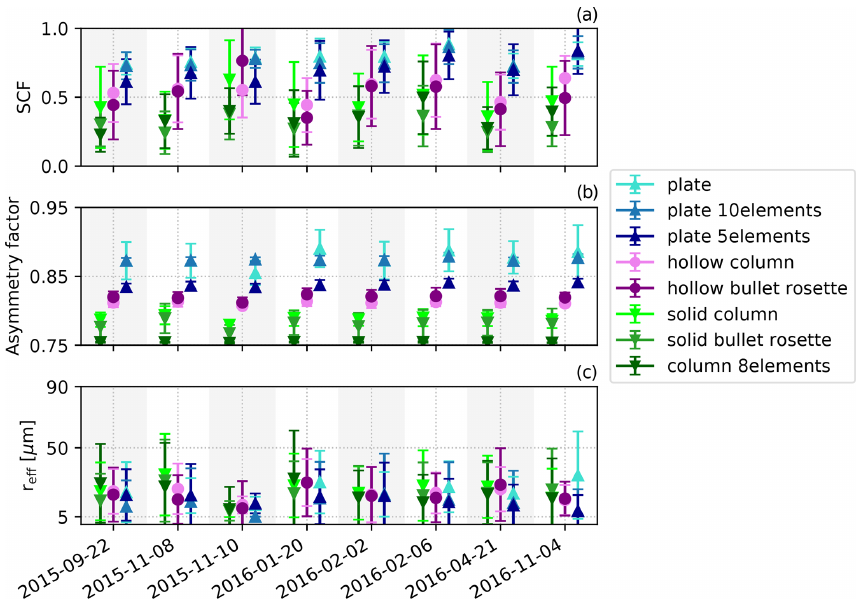
Figure 6. Retrieval results for all 8d listed in Table 1 and for all eight crystal shapes of the YG13 optical property database. Results are shown for the SCF (a) , asymmetry factor (b) , and effective radius (c) using the mean value within a 1 σ confidence interval. Note that the underlying distributions might be skewed as depicted in Fig. 5. Blue (triangles up), pink (circles), and green color tones (triangles down) are used to group the ice crystal shapes into plate-like, hollow, and columnar shapes, respectively. Darker colors indicate more complex crystals.